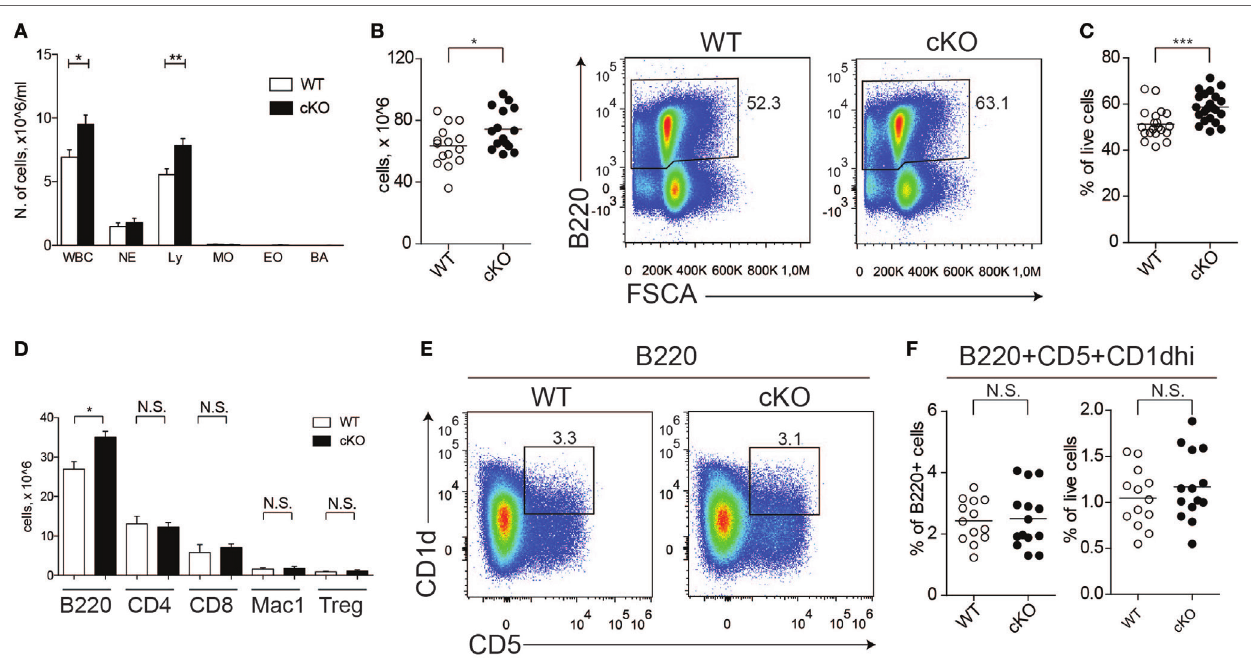
FigUre 1 | Lack of glucocorticoid-induced leucine zipper (GILZ) in B cells increases B cell abundance, but not for the B220 + CD5 + CD1d hi [regulatory B (Breg)] subset. (a) Blood cell counts in aged (7- to 8-month olds) wild-type (WT) and gilz B cKO mice; abbreviations in x -axis indicate different blood cell population, as follows: WBC, white blood cells; NE, neutrophils; Ly, lymphocytes; MO, monocytes; EO, eosinophils; BA, basophils. (B) Total number of cells in the spleen of WT and gilz B cKO mice. (c) Flow cytometry analysis of B220 + expression in the spleen of WT and gilz B cKO mice. The graph on the right represents the frequency of B220 + cells in the spleen. (D) Number of leukocyte subsets, reported as B220 + B cells (B220), CD4 + T cells (CD4), CD8 + T cells (CD8), Mac1 + Gr1 − monocytes/ macrophages (Mac1), Cd4 + FoxP3 + regulatory T cells (Tregs), in the spleen of WT and gilz B cKO mice ( n = 14, 15). (e) Flow cytometry analysis of Breg cells in the spleen of WT and gilz B cKO mice. (F) Frequency and number of Breg cells in the spleen of WT and gilz B cKO mice ( n = 12). N.S., not significant; statistical analysis was performed using the unpaired Student’s t -test (* p < 0.05, ** p < 0.005, *** p <